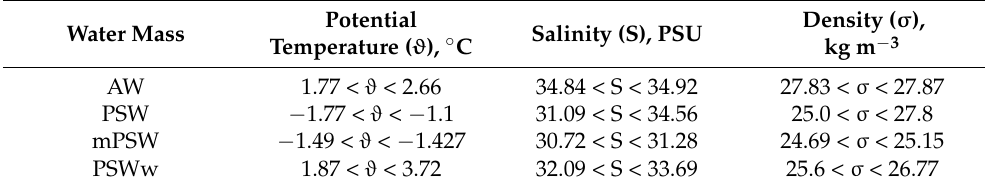
Table 1. Changes in temperature, salinity, and density in the core of AW and PW, as well as the mini- mum temperature in mPSW and maximum temperature in PSWw at the stations of the studied area. Water Mass